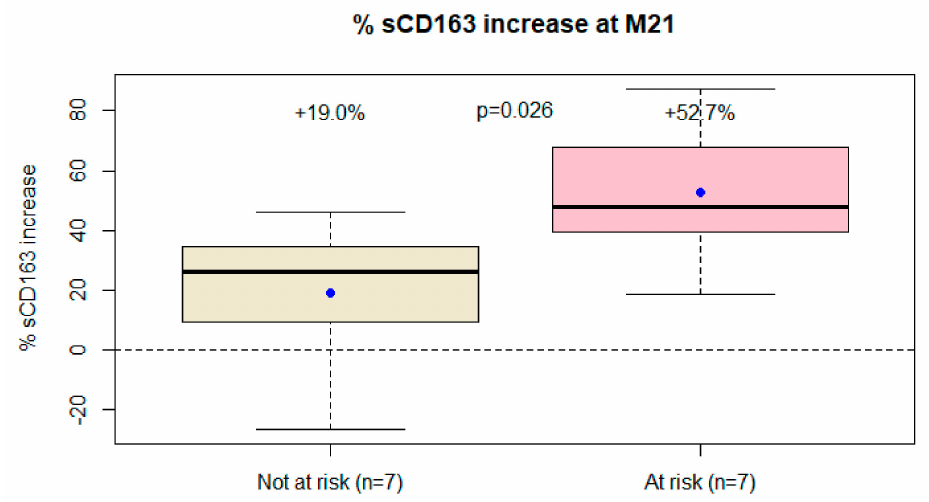
Figure 2. Differences in sCD163 trajectory from baseline to the end of follow-up between patients at risk of immune activation (i.e., CD4 nadir < 200 cc/mm 3 , previous AIDS, or very low-level viremia during the follow-up) and those not at